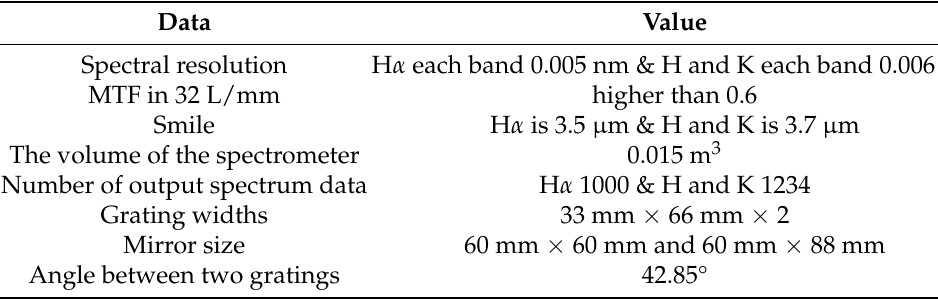
Table 3. Data obtained through